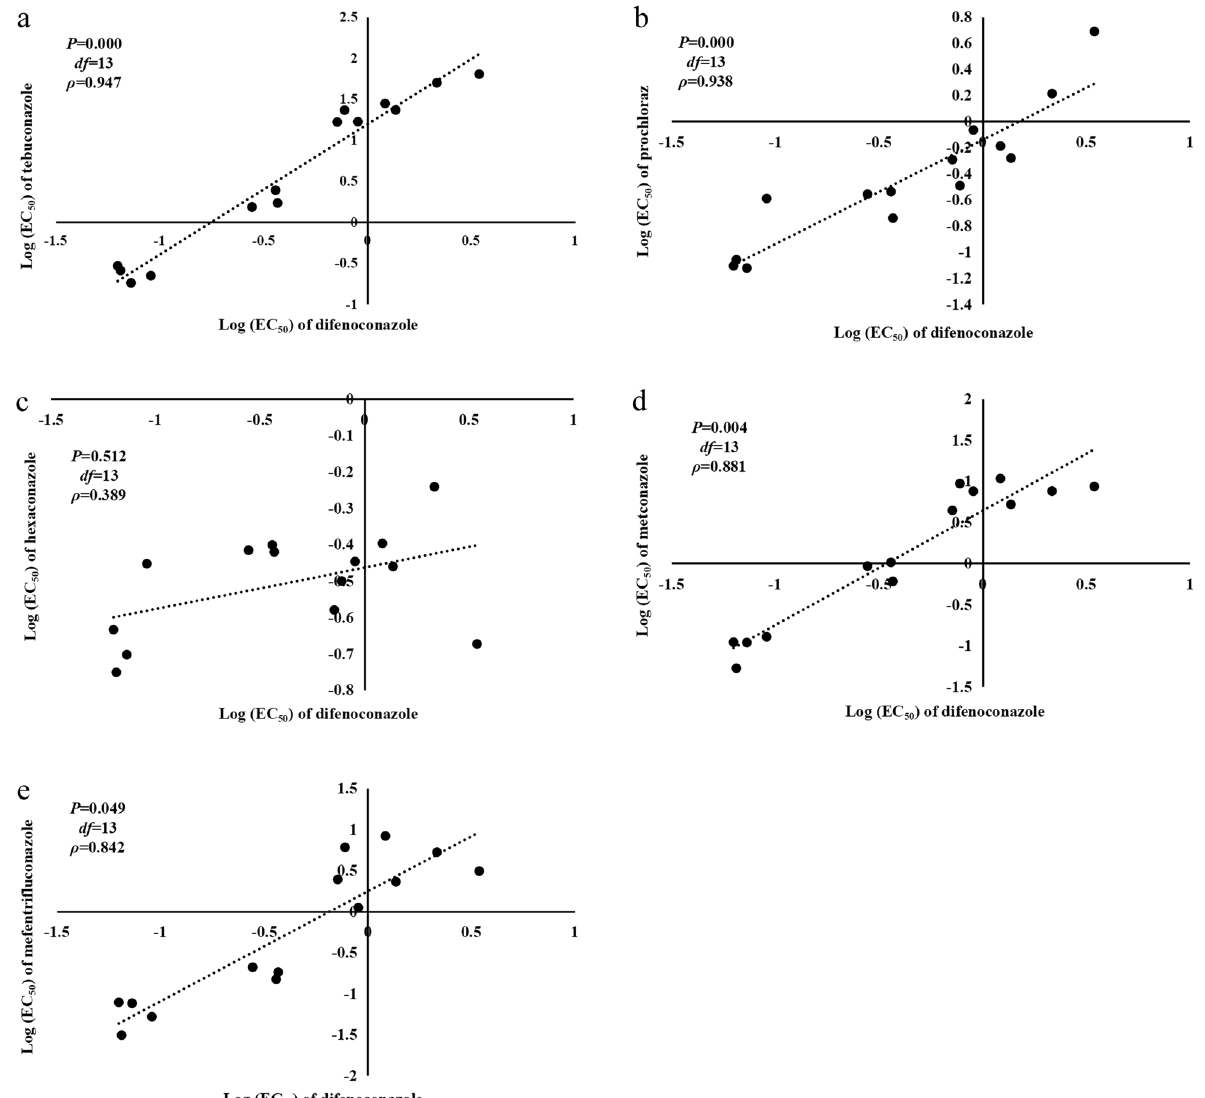
Fig. 1 Cross-resistance among difenoconazole and tebuconazole ( a ), prochloraz ( b ), hexaconazole ( c ), metconazole ( d ), and